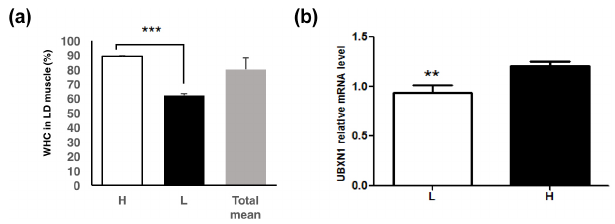
Figure 1. The UBXN1 expression level in longissimus dorsi muscle of pigs with the low and high WHC. (a) The WHC (%) of porcine longissimus dorsi muscle in the low (L), high (H) and total WHC groups. (b) The UBXN1 expression level in the low (L) and high (H) WHC groups. The mRNA levels were normalized to RPLP0 mRNA levels. The data shown in figures are arithmetic means ± standard error of the mean (SEM). n = 16 for each group. ∗∗∗ P< 0 . 001. ∗∗ P< 0 .